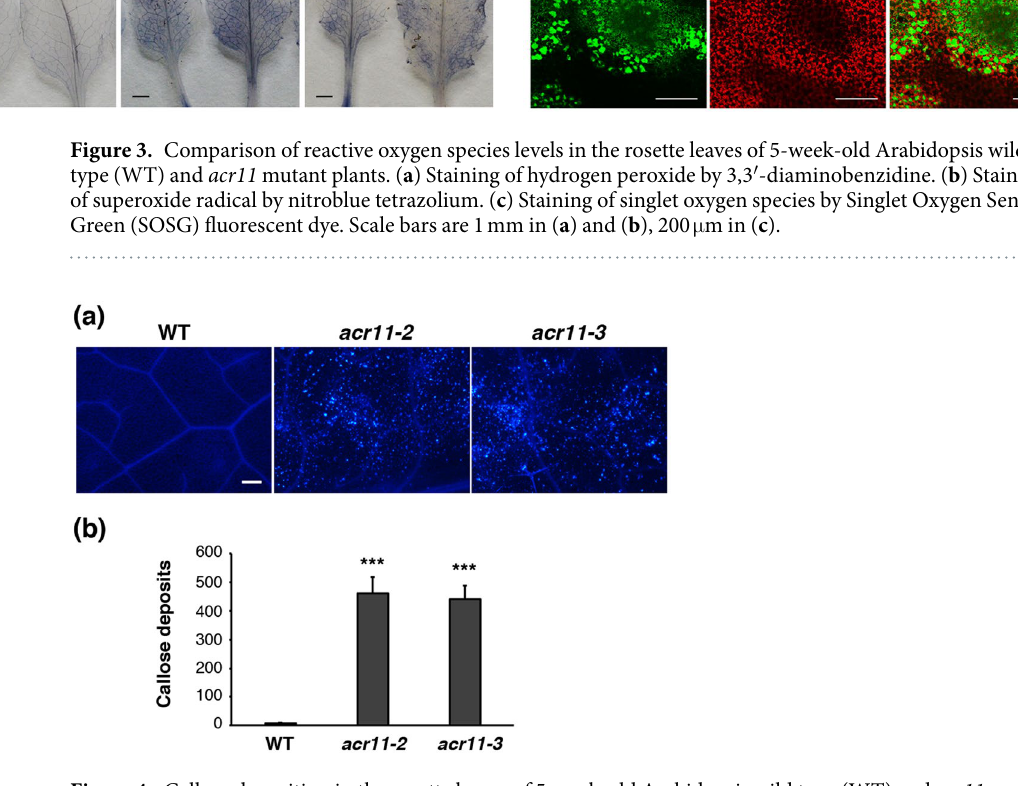
Figure 4. Callose deposition in the rosette leaves of 5-week-old Arabidopsis wild type (WT) and acr11 mutants. ( a ) Staining of callose deposits by aniline blue. Scale bar is 100 μ m. ( b ) Quantification of callose deposits in WT and acr11 mutant leaves. Values shown are means ± SD per 0.97 mm 2 from leaves of 5 independent plants. *** P < 0.001 represents the result of Student’s t